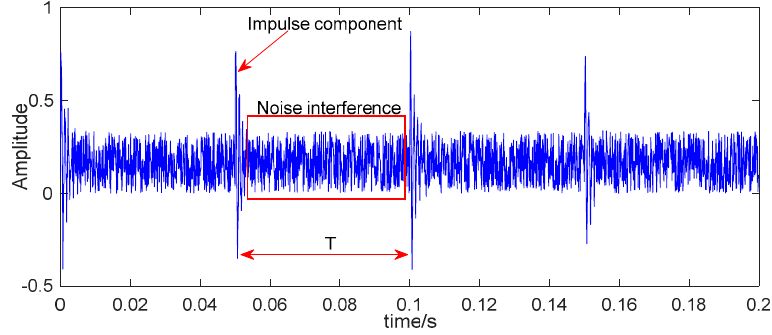
Figure 1. Simulated signal of the impact damage.